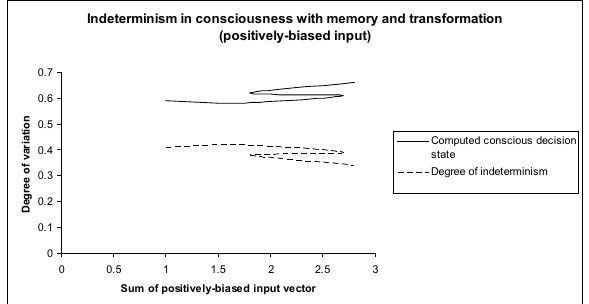
Fig. 30. Consciousness in complete memory system (transformed excitation, +biased